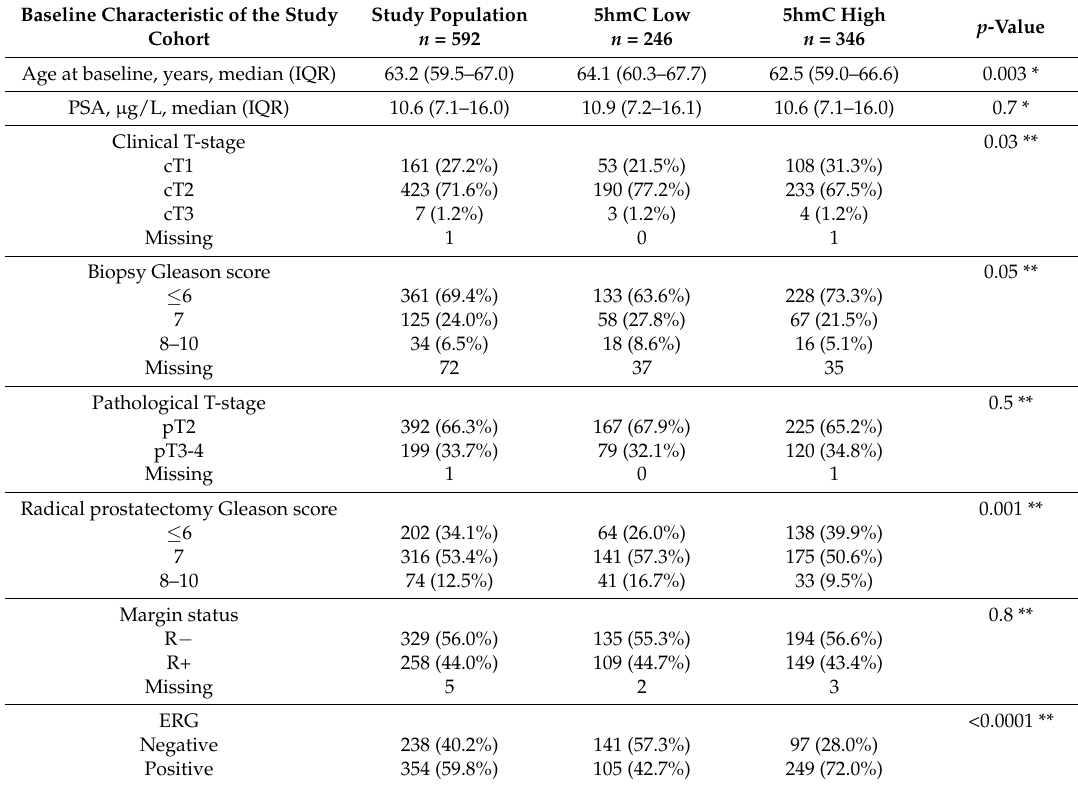
Table 1. Baseline characteristics of the study